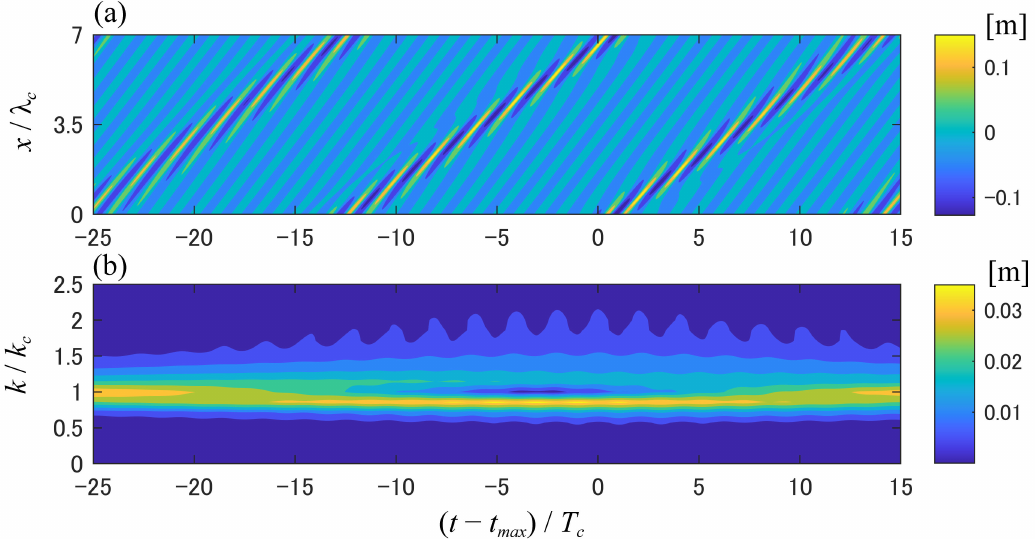
Figure 5. Temporal evolution of the modulated wave train with a 0 k c = 0.105 near the time of the maximum crest height ( t = t max ) in the HOSM simulation. ( a ) Wave elevation ζ ( x , t ) ; ( b ) amplitude (cid:12) (cid:12) spectrum (cid:12) ˆ ζ ( k , t ) (cid:12) .